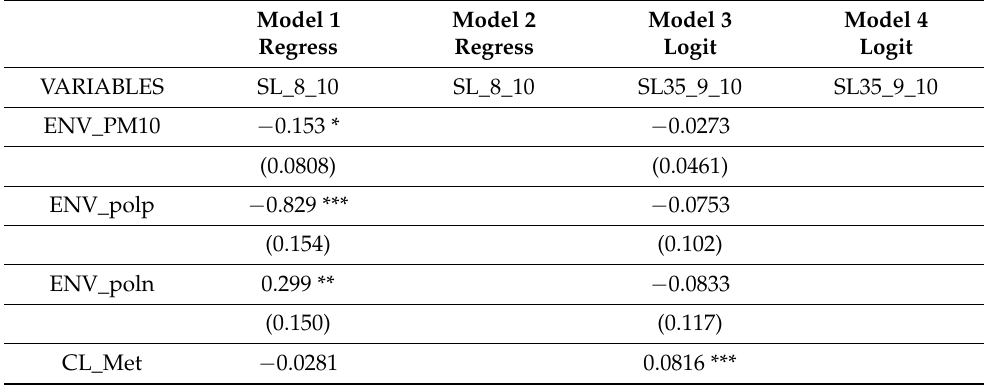
Table 1. Logit and linear regression